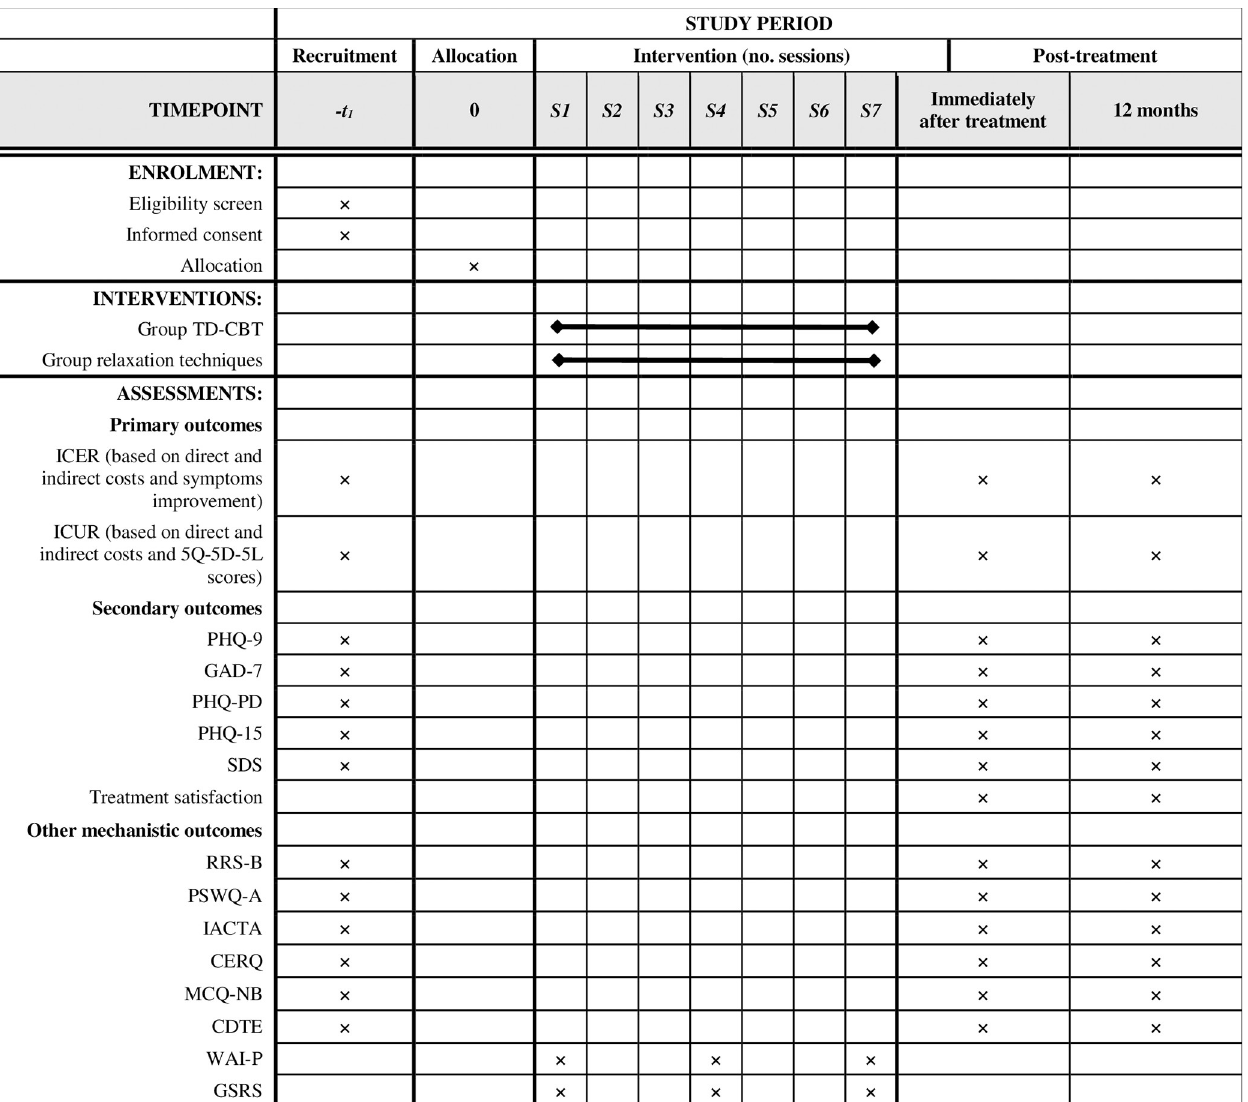
PLOS ONE | https://doi.org/10.1371/journal.pone.0283104 March 16,